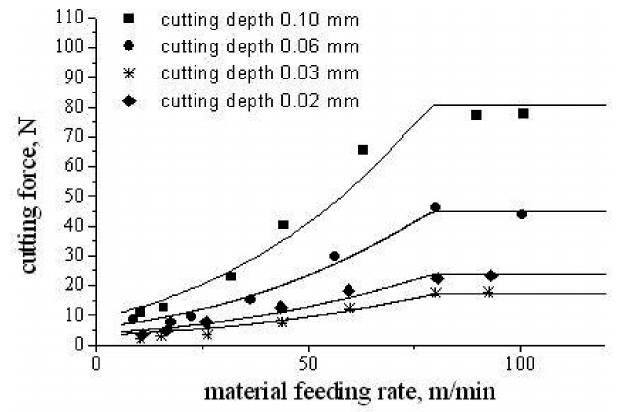
Fig. 6. Effect of material feeding rate on average cutting force as a function of for ultrasonically- assisted cutting of aluminium; f = 20 kHz, λ = 10 µ m, F 0 = 3 N. Comparison of calculations (solid line) and experimental data. The level of cutting force in the case of quasi-static load, that depends on the cutting depth, is defined by the value of ρ . The duration of pulsed interaction is inversely proportional to the ultrasonic vibration frequency.